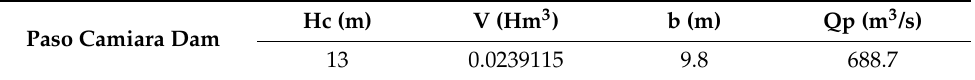
Table 10. Instantaneous discharge flow due to breach of the Paso Camiara informal embankment. Paso Camiara